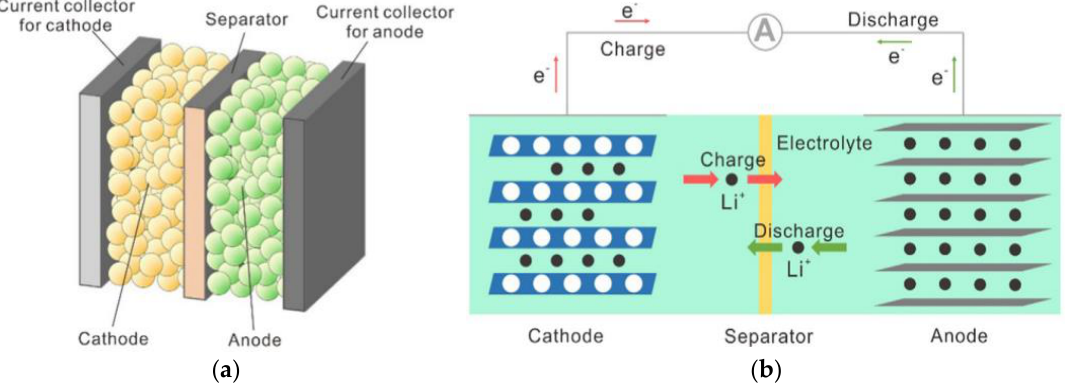
Figure 1. ( a ) Schematic diagram of lithium battery structure. Reprinted with authorization of [31]. Copyright: 2017, Elsevier; ( b ) Working principle diagram of lithium battery. Reprinted with autho- rization of [32]. Copyright: 2018, Elsevier. Table 2. Lithium battery technical parameters.